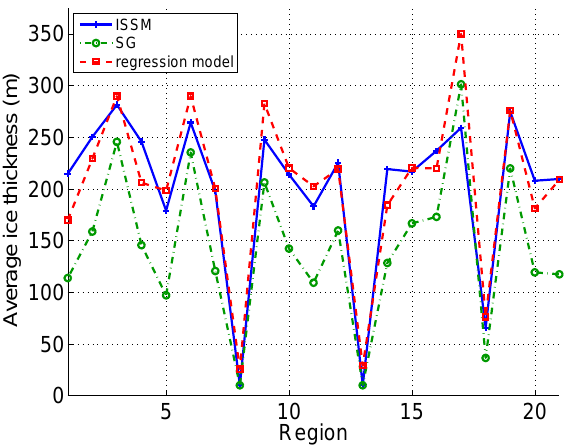
Figure 6. Average ice thickness in metres for different topographic regions in the Rockies. Results are shown for the ISSM, the regres- sion model (generated by the stepwise regression fit including only the standard deviation of the topography) and the SG model using 10 hypsometric bins.